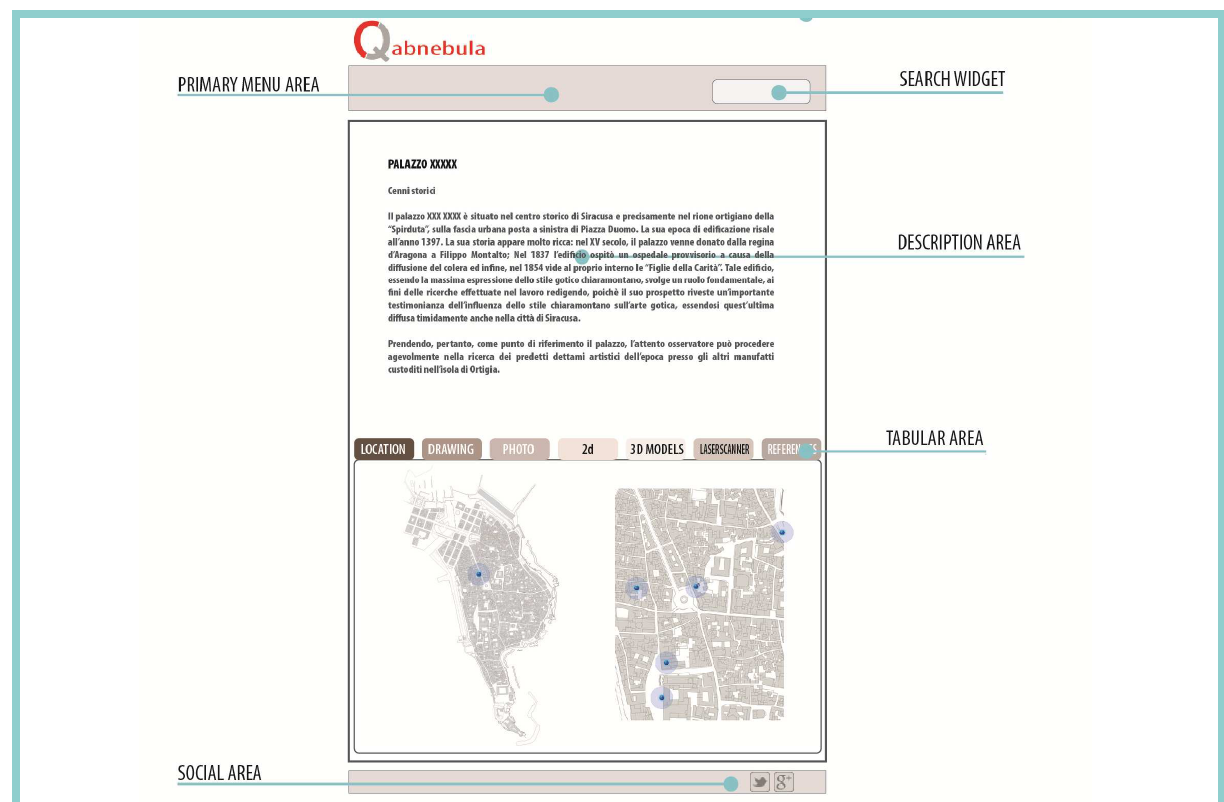
Figure 6. Crabnebula software.